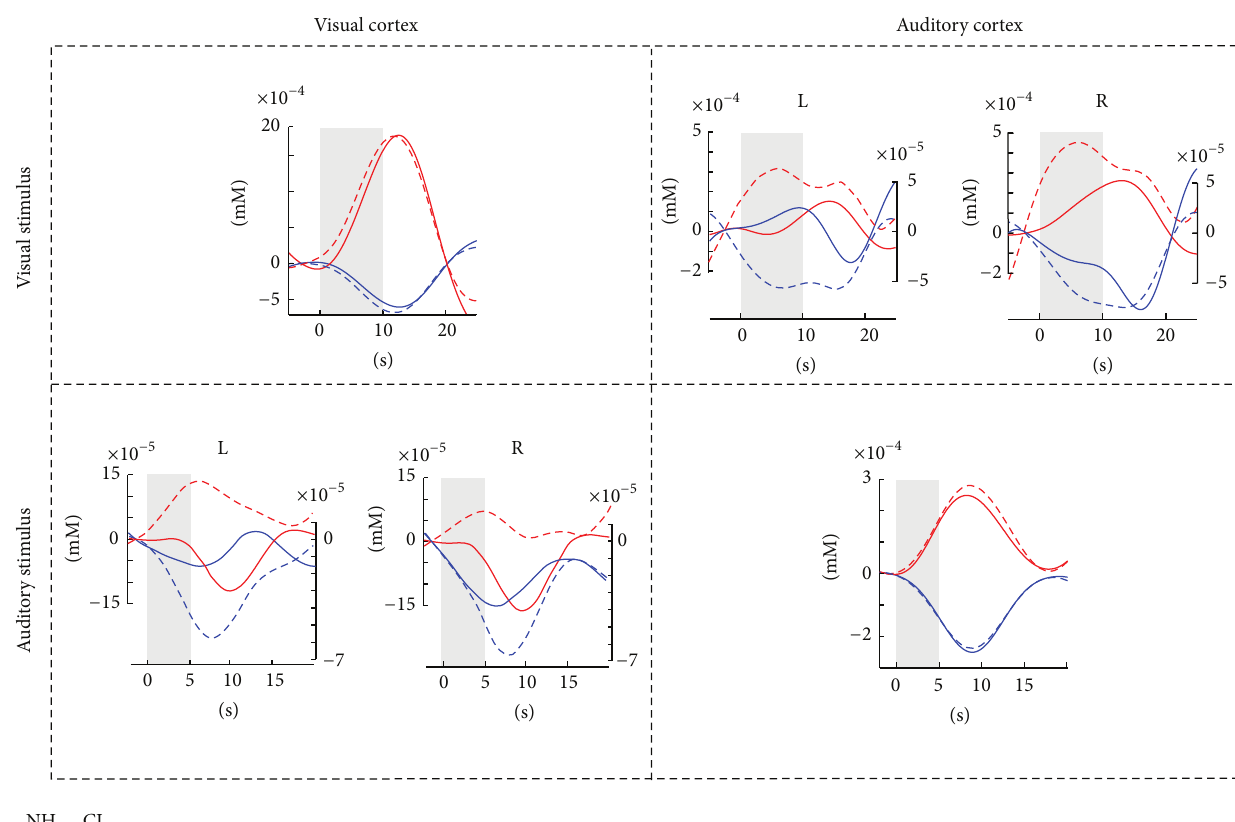
Figure 3: Grand averages of HbO and HbR concentrations forvisual and auditory stimuli.Theoverall layout isidentical toFigure 1. Theupper row represents visual stimuli and the lower row represents auditory stimuli, both averaged over all conditions. The left column represents measurement over visual cortex and the right column represents measurement over auditory cortex. For the cross-modal responses (upper right and lower left), the activations are plotted separately for left and right hemispheres. Additionally, HbO and HbR concentrations are plotted with separate scales, the right for HbR and the left for HbO. For the intramodal responses (upper left and lower right), the activations were averaged across left and right hemispheres. One can see from the plot that the intramodal responses show almost no difference between groups, whereas the cross-modal responses show larger activation for CI users compared to NH controls.